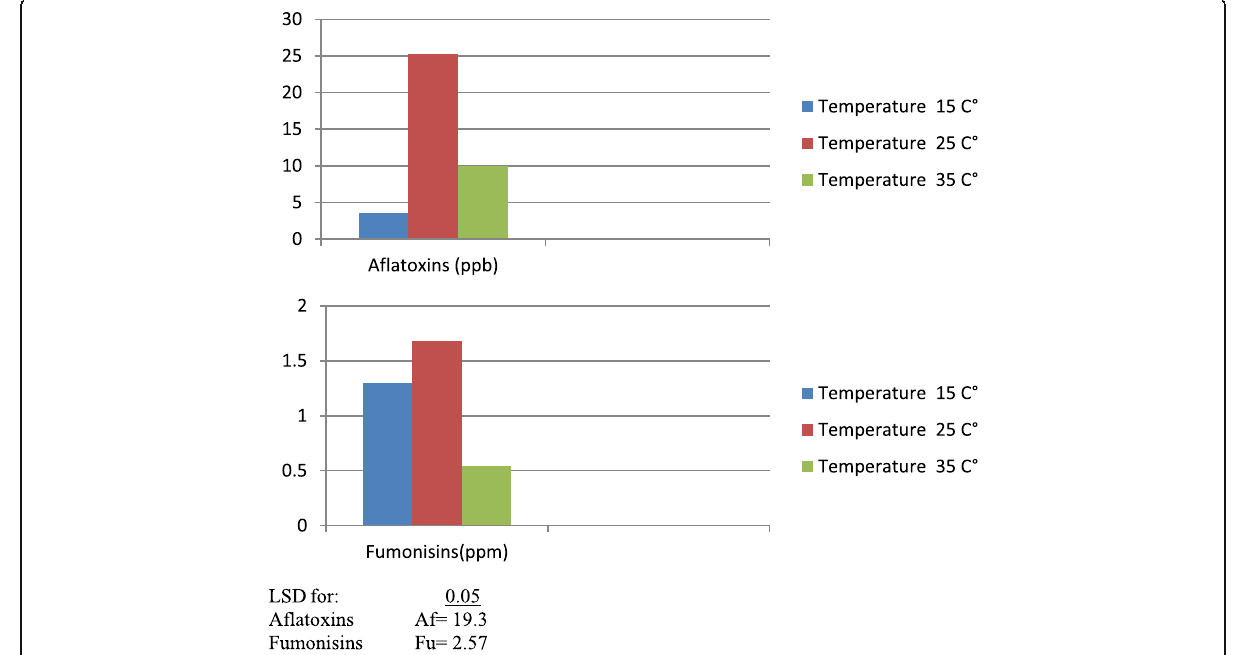
Fig. 4 Effect of three levels of temperature on aflatoxins and fumonisins produced by A. flavus and F.